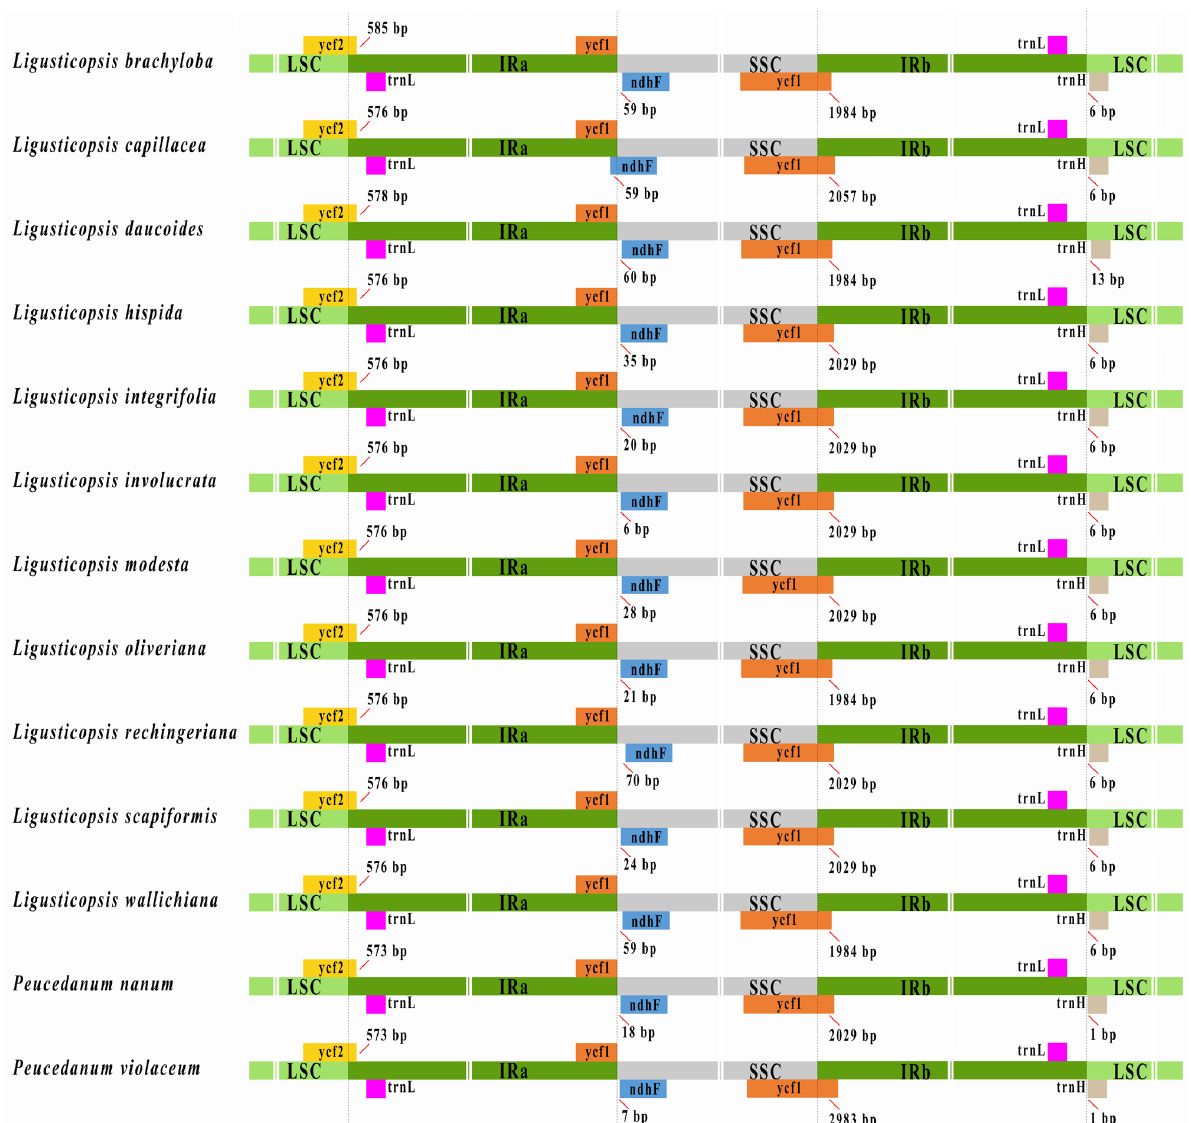
Figure 5. Comparison of IR borders among thirteen plastomes.